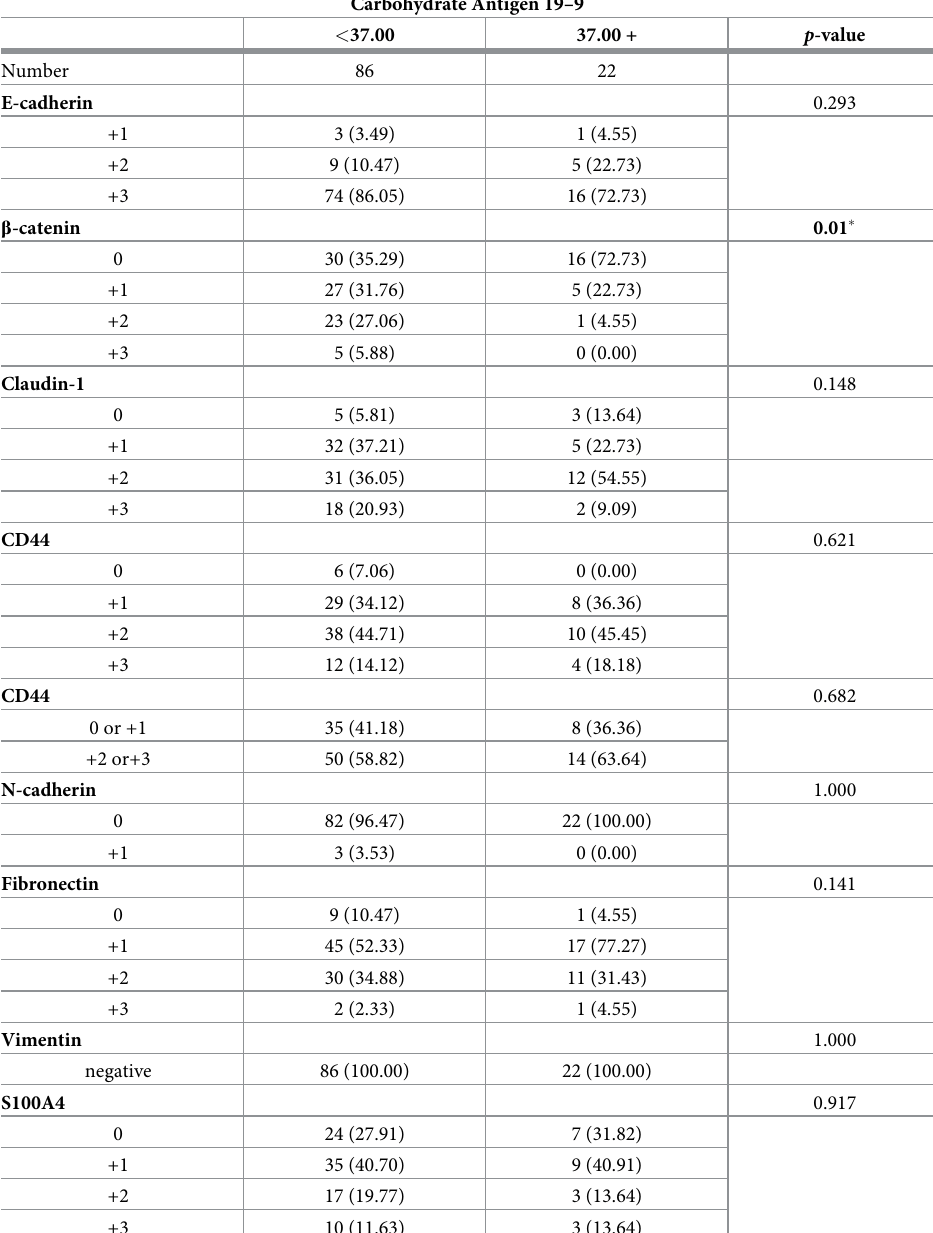
Table 8. IHC expression of EMT-related markers vs . serum levels of CA 19–9. Carbohydrate Antigen